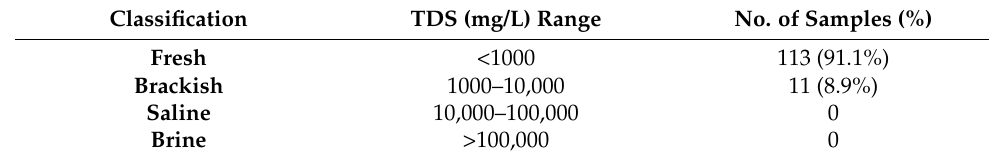
Figure 3. Spatial distribution of TDS in the Soutpansberg region.